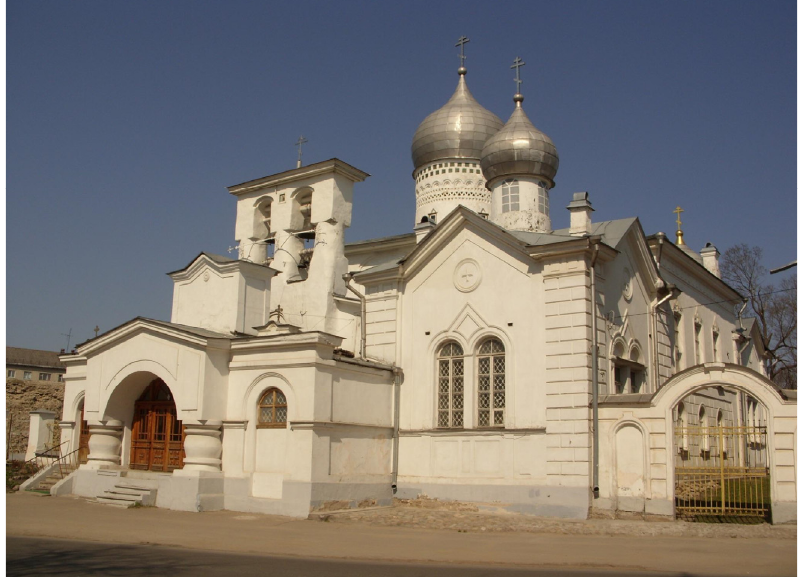
Figure 9. Church of St. Varlaam of Khutyn in Pskov, built in 1495 on the site where a one-day church, also dedicated to St. Varlaam of Khutyn, was erected in 1466. Photograph by S.A. Gavrilov, 2011 (Gavrilov 2011), Wikimedia Commons.